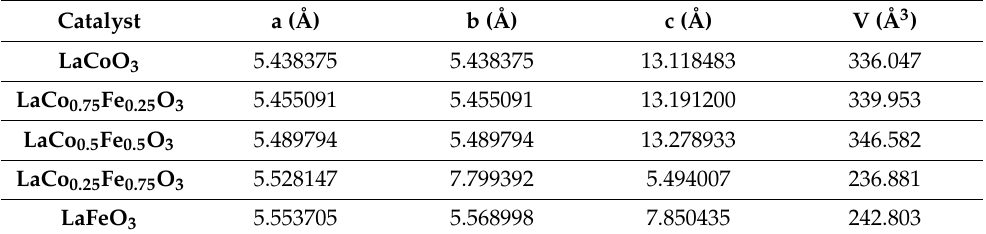
Table 3. Cell parameters of the synthesized structures.